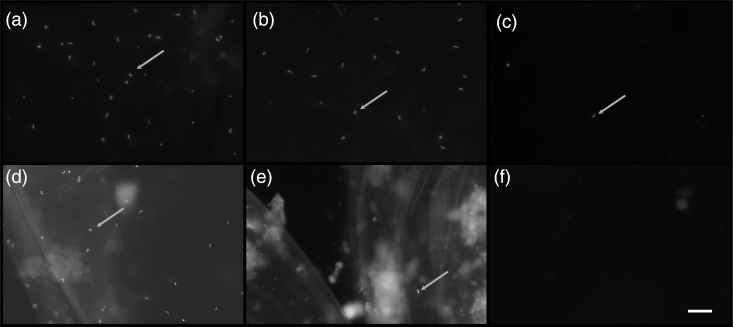
Detection of sperm bound on perivitelline membranes by Hoechst 33342 staining in fresh chicken egg (a), chicken eggs stored at room temperature (20–22°C) for 15 (b) and 30 days (c), chicken eggs stored at refrigeration temperature (4°C) for 30 days (d) and chicken eggs stored at incubation temperature (37.5°C) for 15 (e) and 30 days (f). Arrows indicated sperm heads. Bar represents 50 μm in all panels.